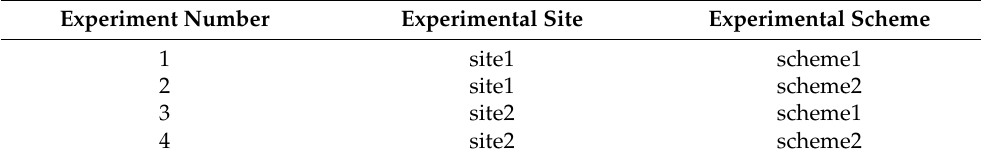
Table 3. Experimental